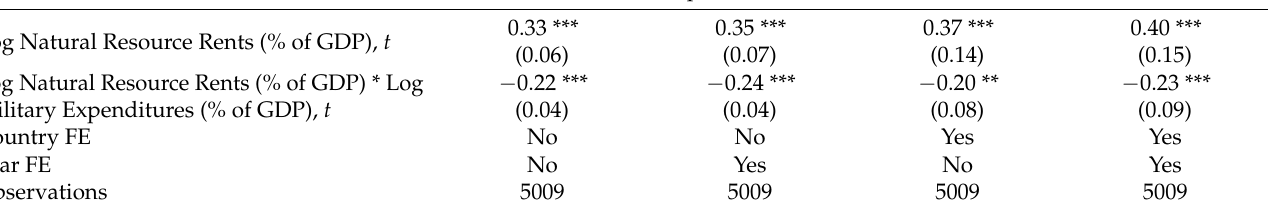
Panel B: Excluding Countries at or below the Bottom 10th Percentile of Military Expenditures (Less Than 0.8% of